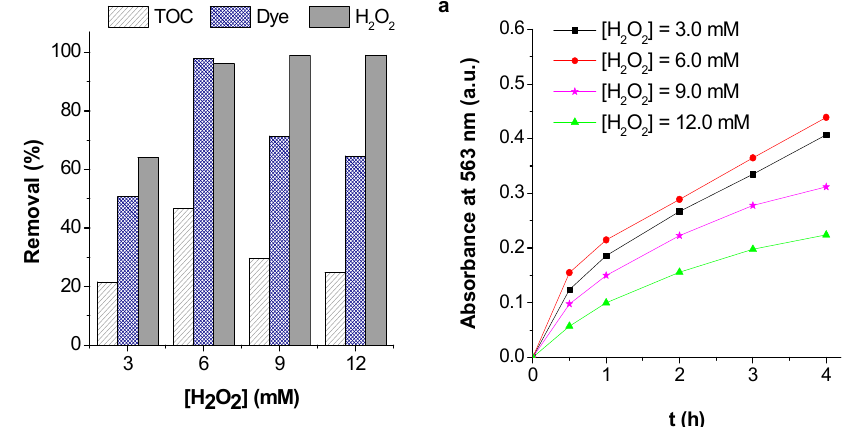
Figure 8. Effect of hydrogen peroxide concentration in dye and TOC removals and hydrogen Figure 8. E ff ect of hydrogen peroxide concentration in dye and TOC removals and hydrogen peroxide peroxide consumption after 4 h of reaction (a) and hydroxyl radicals formation during CWPO (b) for consumption after 4 h of reaction ( a ) and hydroxyl radicals formation during CWPO ( b ) for a Au / Al 2 O 3 a Au/Al 2 O 3 catalyst ([OII] a) = 0.1 mM or [OII] b) = 0.0 mM, [catalyst] = 2.0 g/L, T = 30 °C and pH initial = catalyst ([OII] a) = 0.1 mM or [OII] b) = 0.0 mM, [catalyst] = 2.0 g / L, T = 30 ◦ C and pH initial = 3.0). 3.0). Adapted from Rodrigues et al. [66]. Adapted from Rodrigues et al.